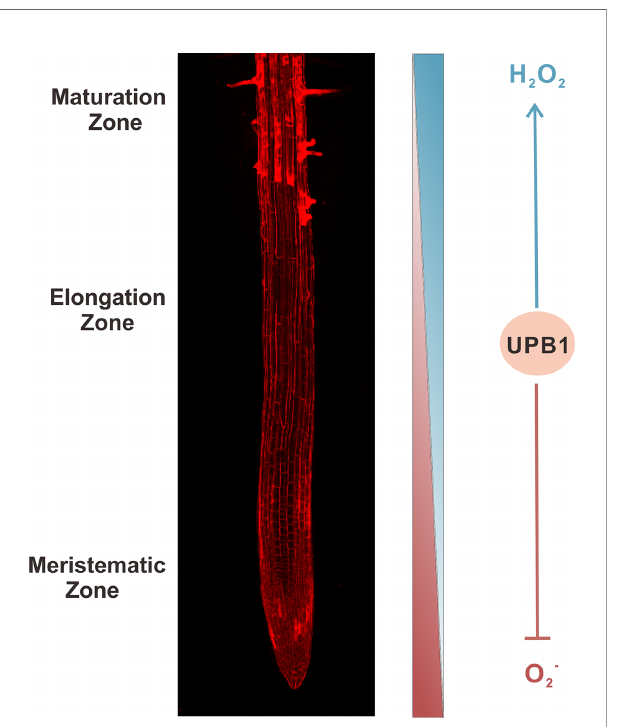
FIGURE 2 | Reactive oxygen species (ROS) mediate root stem cell maintenance. pWOX5 : GFP marks the quiescent center (QC) in Arabidopsis roots. Multiple parallel signaling pathways integrate multiple transcription factors to converge as an ROS signal to regulate root stem cell maintenance. APP1 is upregulated, and ABO8 and PHB3 inhibit H 2 O 2 signals, thus stimulating ERF109/114/115 or inhibiting WOX5. ERF109/114/115 negatively regulates root stem cell maintenance, whereas WOX5 positively regulates it. Another cascade pathway converges on RITF1 to regulate the level of H 2 O 2 and O 2 (cid:129) − , and its downstream products regulate PLT1/2, thus controlling stem-cell fate. Furthermore, the brassinolide signaling pathway regulates the level of BRAVO and stem-cell fate in the roots. Arrow-head line indicates stimulation effect, and “ T ” -shaped line shows the